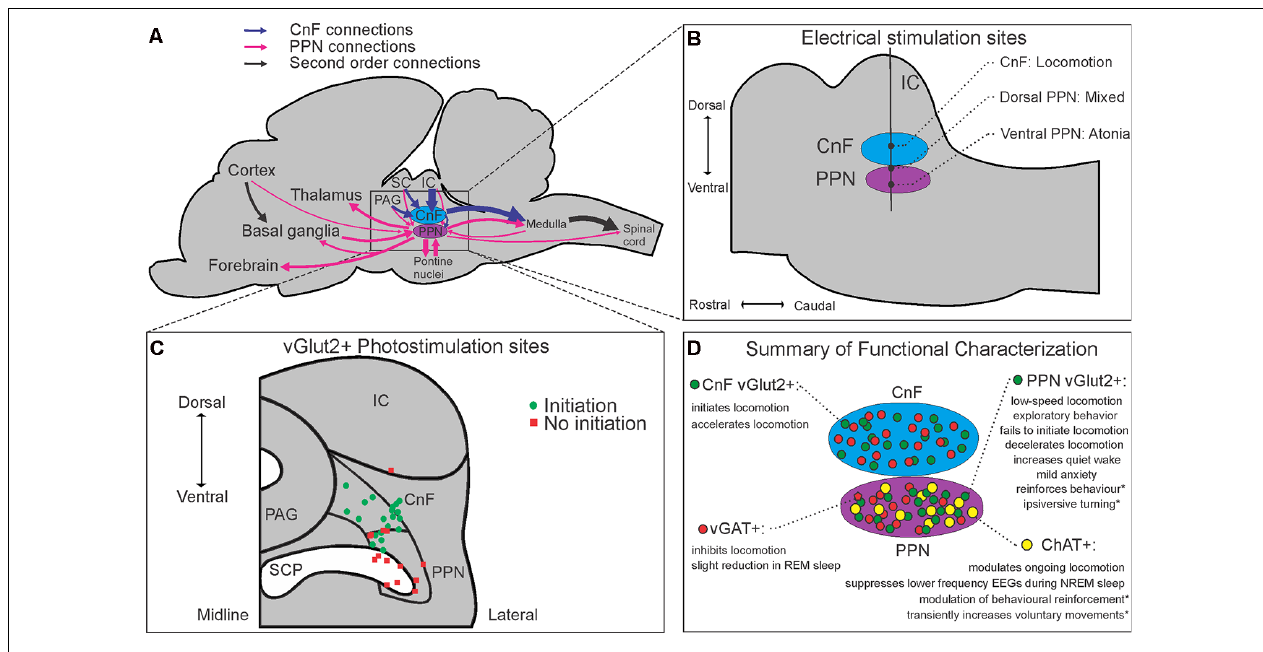
FIGURE 1 | Anatomical, neurochemical, and connectome-based characterizations of the mesencephalic locomotor region (MLR). Schematic summaries of (A) major inputs and outputs of the CnF and PPN in rodents, (B) anatomical electrical mapping of the MLR in cats from Takakusaki et al. (2016), (C) CnF and PPN vGlut2+ photostimulation results from Josset et al. (2018) and (D) cell-type-specific functional characterizations of the CnF and PPN reported in the literature. Abbreviations: ChAT, choline acetyltransferase; CnF, cuneiform nucleus; IC, inferior colliculus; PAG, periaqueductal gray; PPN, pedunculopontine nucleus;